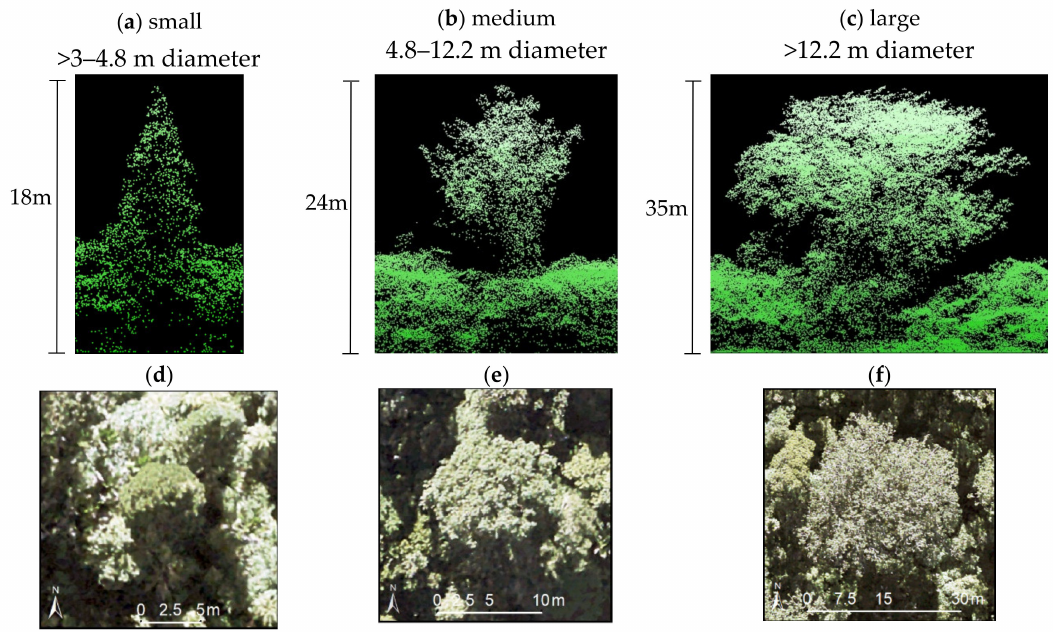
Figure 1. Kauri crown size classes: Non-symptomatic small, medium, and large kauri crowns, as a profile on a Light Detection and Ranging (LiDAR) point cloud ( a–c ) [11] and on 7.5 cm aerial images below ( d–f )